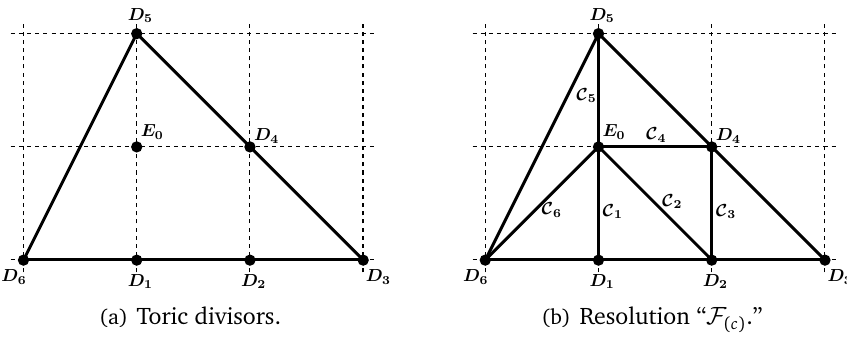
( 0, T ) 2 toric geometry, resolution “(c)” and its curves. 3